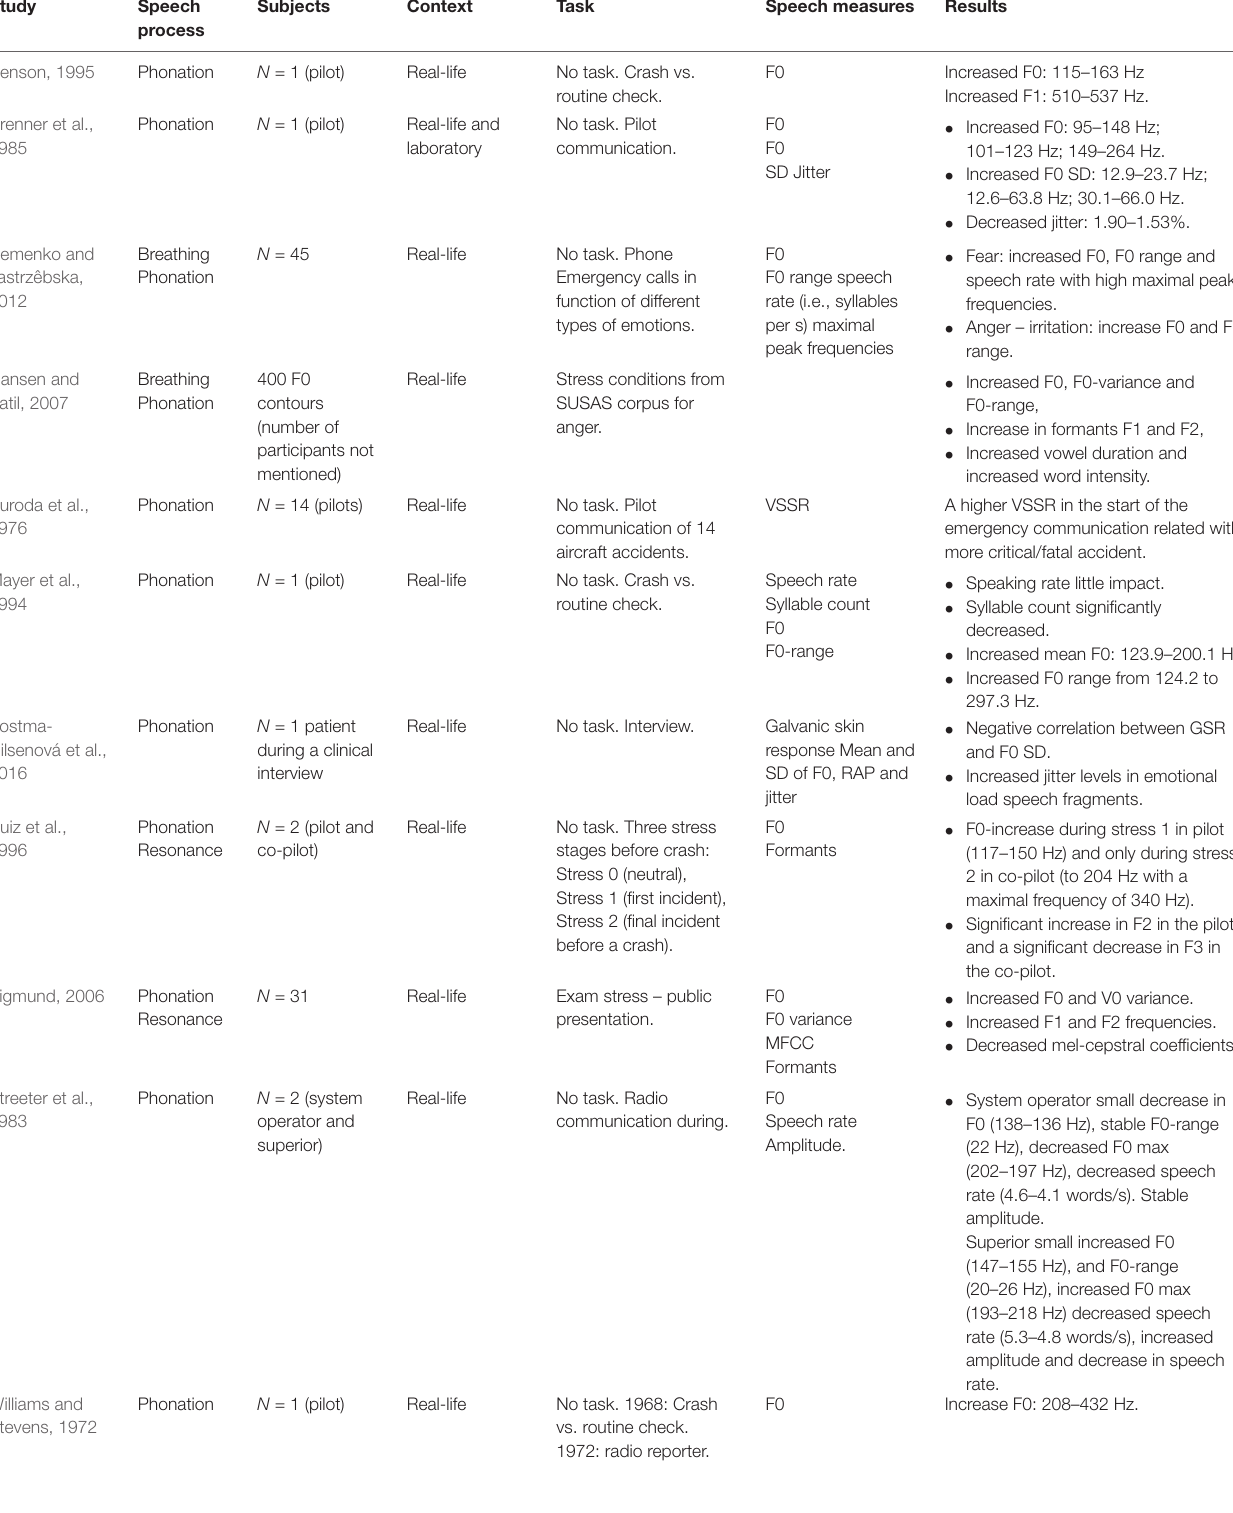
TABLE 5 | Studies on the impact of emotional load on voice and speech